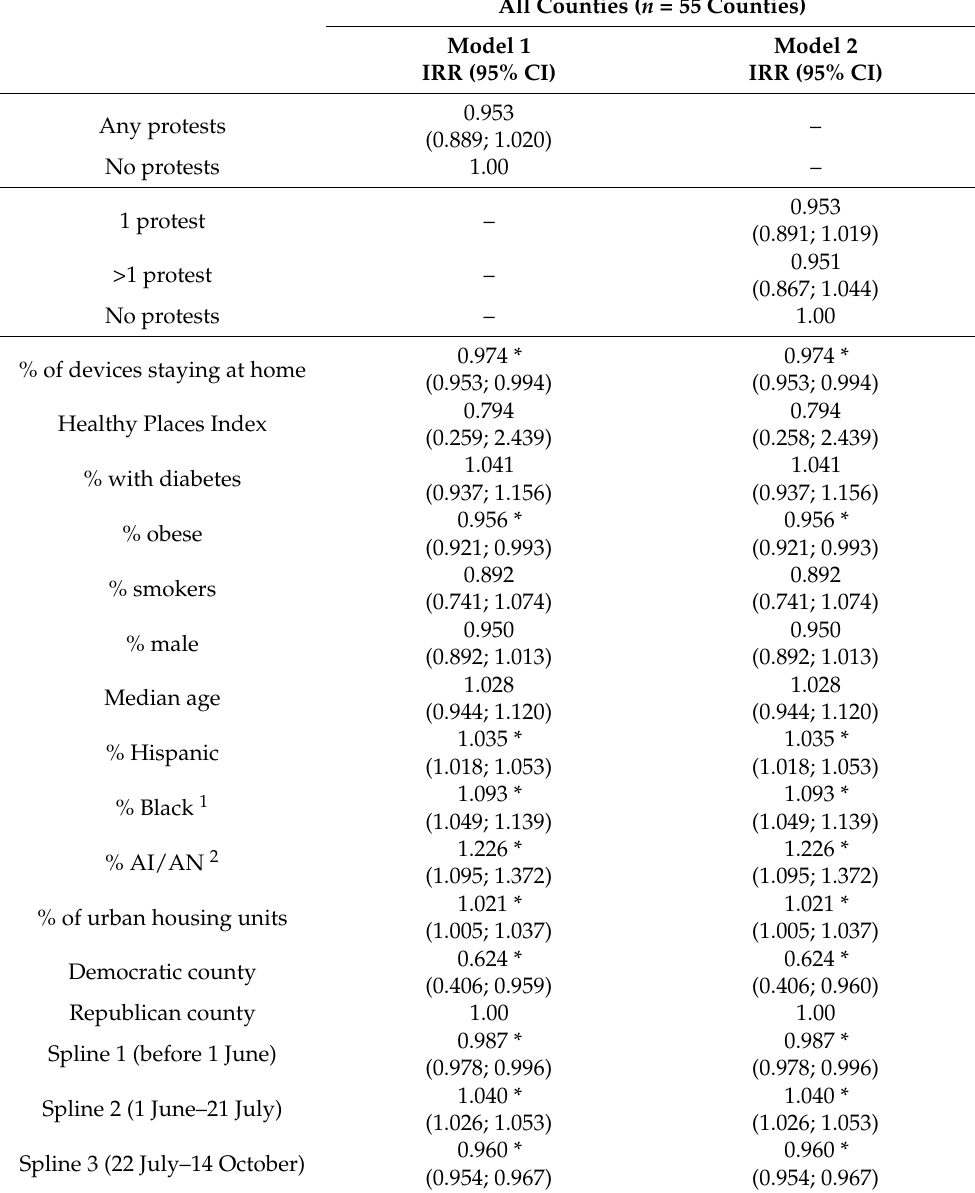
Table 2. Incidence rate ratios (IRR) and 95% Confidence Interval (95% CI) from multivariable mixed- effect negative binomial models: Association between protests and two-week post-protest